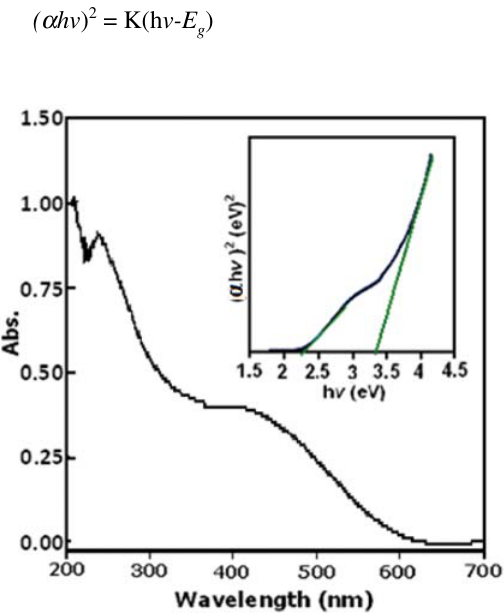
Figure 9. UV-Vis spectrum and ( α h v ) 2 -h v curve (inset) of the Co O nanoparticles. 3 4